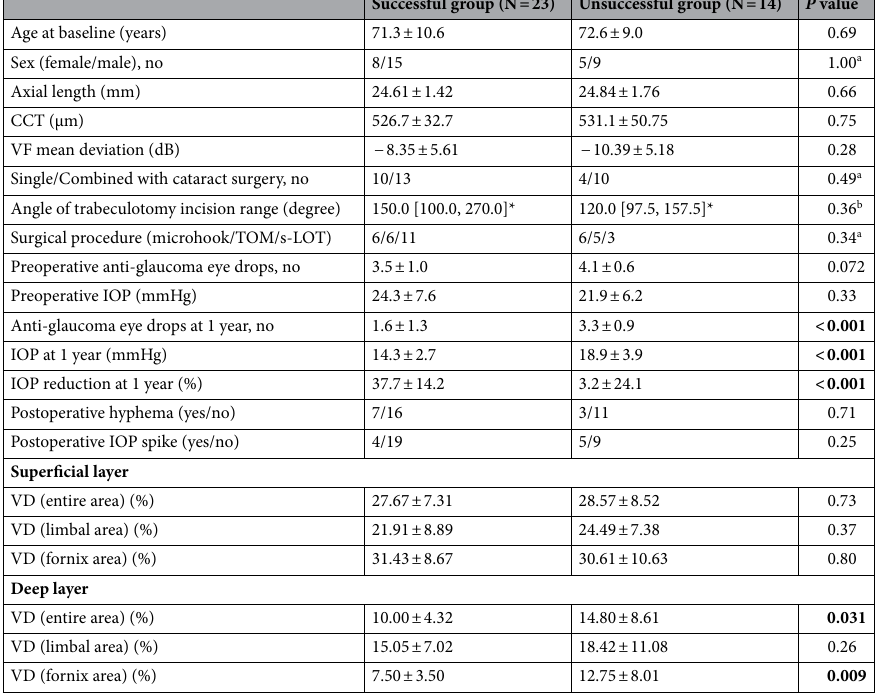
Table 2. Comparison between successful and unsuccessful groups (N = 37). Statistically significant values ( P < 0.05) are shown in bold. Data are presented as the mean ± standard deviation unless otherwise indicated. *Data are presented as the median [25-th percentile, 75-th percentile]. CCT = central corneal thickness; IOP = intraocular pressure; s-LOT = suture trabeculotomy; TOM = Trabectome; VD = vessel density; VF = visual field. P -value: a Calculated using Fisher’s exact test; b Calculated using the Mann–Whitney U test; The other values were calculated using an unpaired t- test. Success was defined as a postoperative IOP ≤ 18 mmHg and ≥ 20% reduction from preoperative IOP 1 year after surgery (criterion